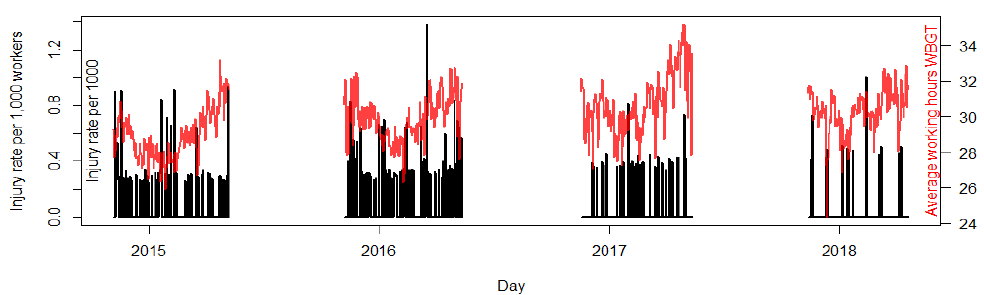
Figure 1. Daily total recorded occupational injury rate per 1000 Southwestern Guatemalan sugarcane temperatures. Harvest seasons run from November to April and are indicated by the annual label on the plot.